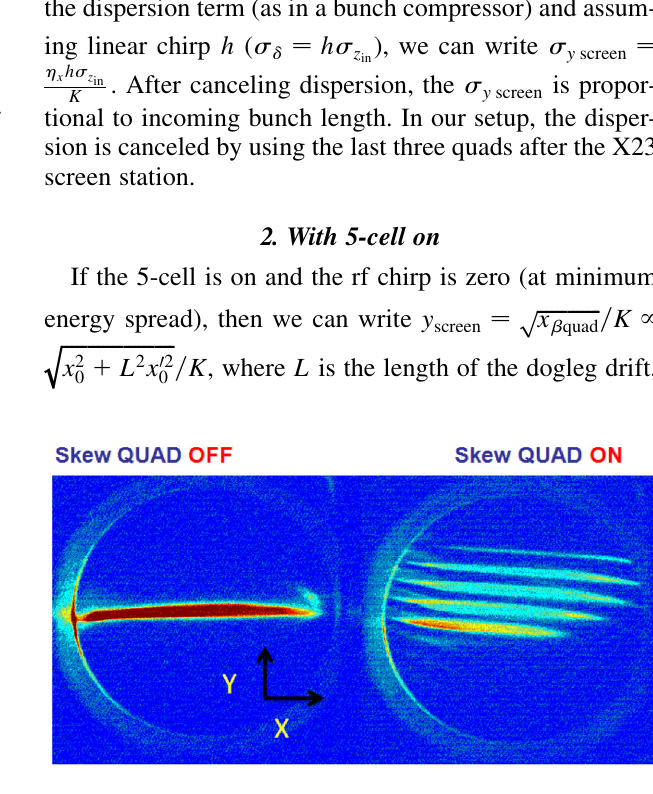
FIG. 8. Measured transverse beam images at X23 with the slits in at X3 and the 5-cell turned on. The skew-quadrupole projects the energy spectrum on the screen when the chirp is zero due to the leakage of the horizontal dispersion to the vertical plane. The observed separation of the slits in the y direction is in good agreement with the simulation shown in Fig.